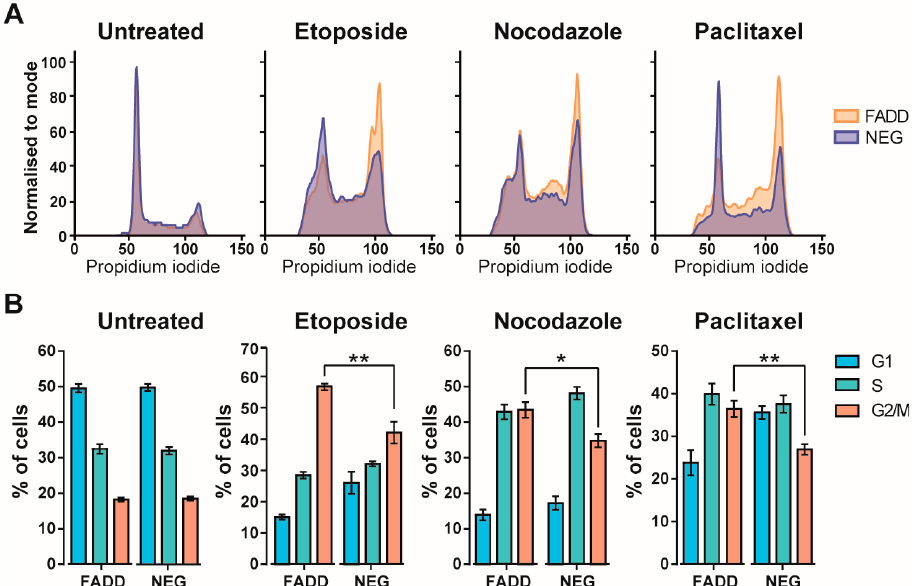
Figure 3. Pharmacological arrest at the G2/M stage of the cell cycle. The cell cycle of the FADD- expressing (FADD) and FADD-deficient (NEG) JURKAT cell lines was evaluated without any treat- ment (untreated) or after treatment with 100 nM etoposide, 50 ng/mL nocodazole, and 10 nM paclitaxel for 18 h. ( A ) Representative histograms of cells stained with propidium iodine showing DNA content distribution. Cell cycle phase distribution was analyzed by flow cytometry. ( B ) Bar chart of cell cycle distribution from six independent experiments. One-way ANOVA was used to test for statistical significance: * p ≤ 0.05; ** p ≤ 0.01. Error bars represent the standard error of the mean (SEM).